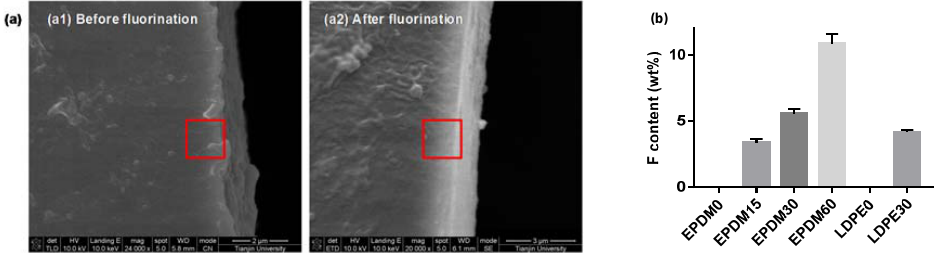
Figure 1. Scanning electron microscope of the ethylene–propylene–diene terpolymer (EPDM) and low density polyethylene (LDPE) cross ‐ section. ( a ) SEM pictures; ( b ) fluorine contents.